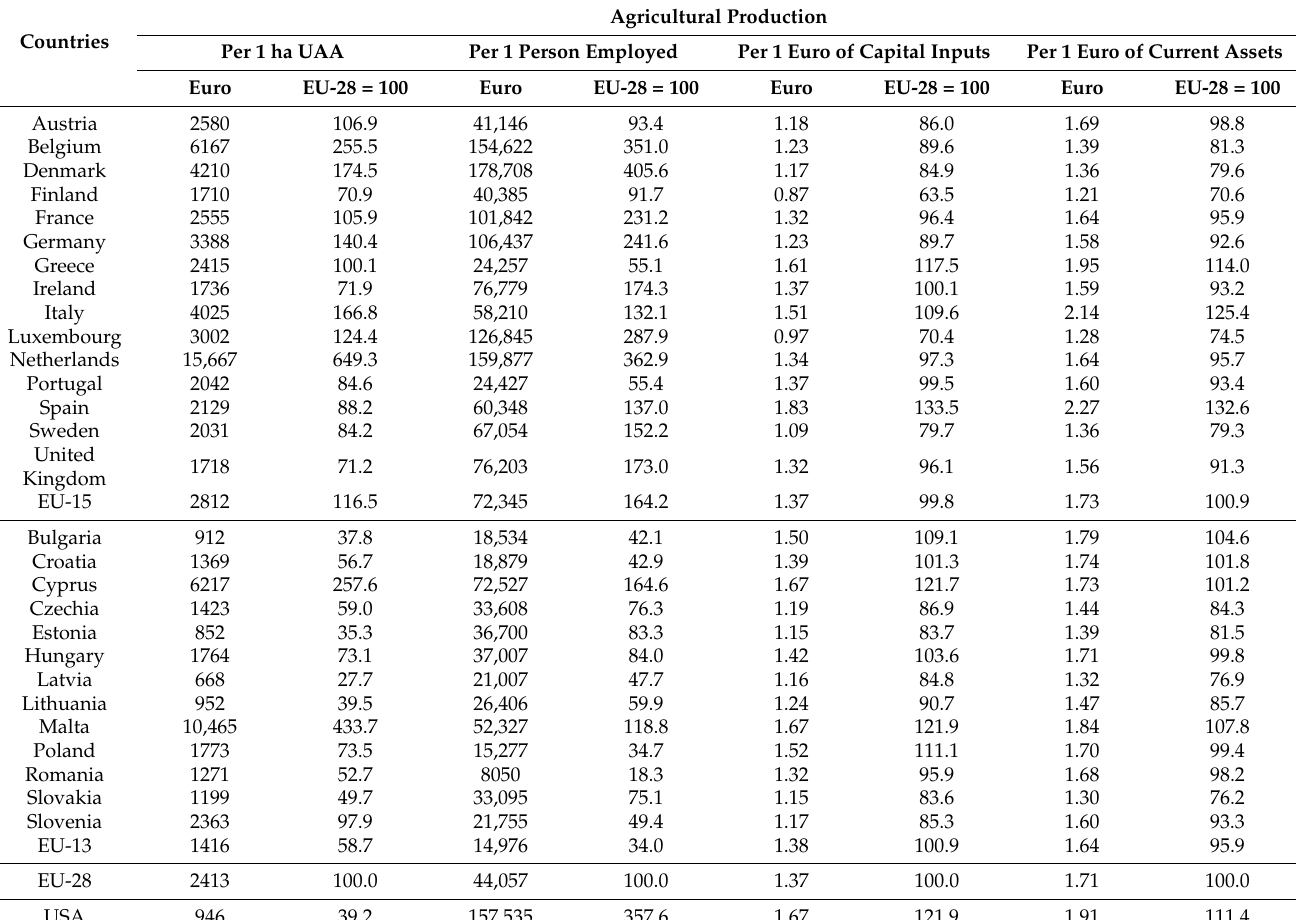
Table 3. Productivity of production factors in the agriculture of the EU and the USA in 2017.